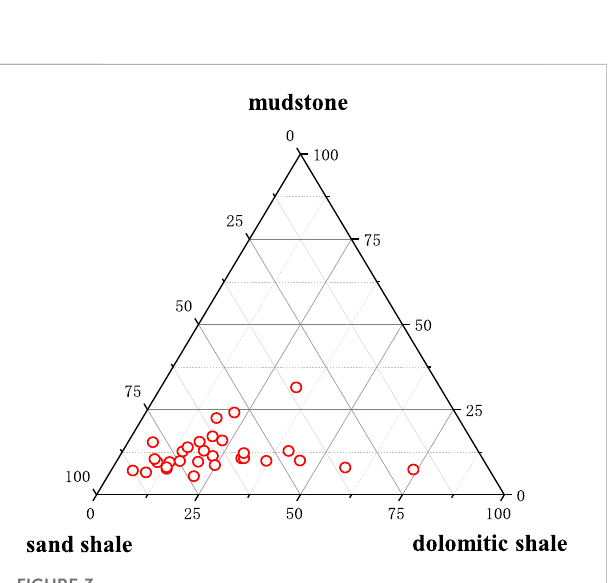
The rock type of Fengcheng Formation includes carbonate rocks, tight sandstones, sedimentary tuffs and mixed sedimentary